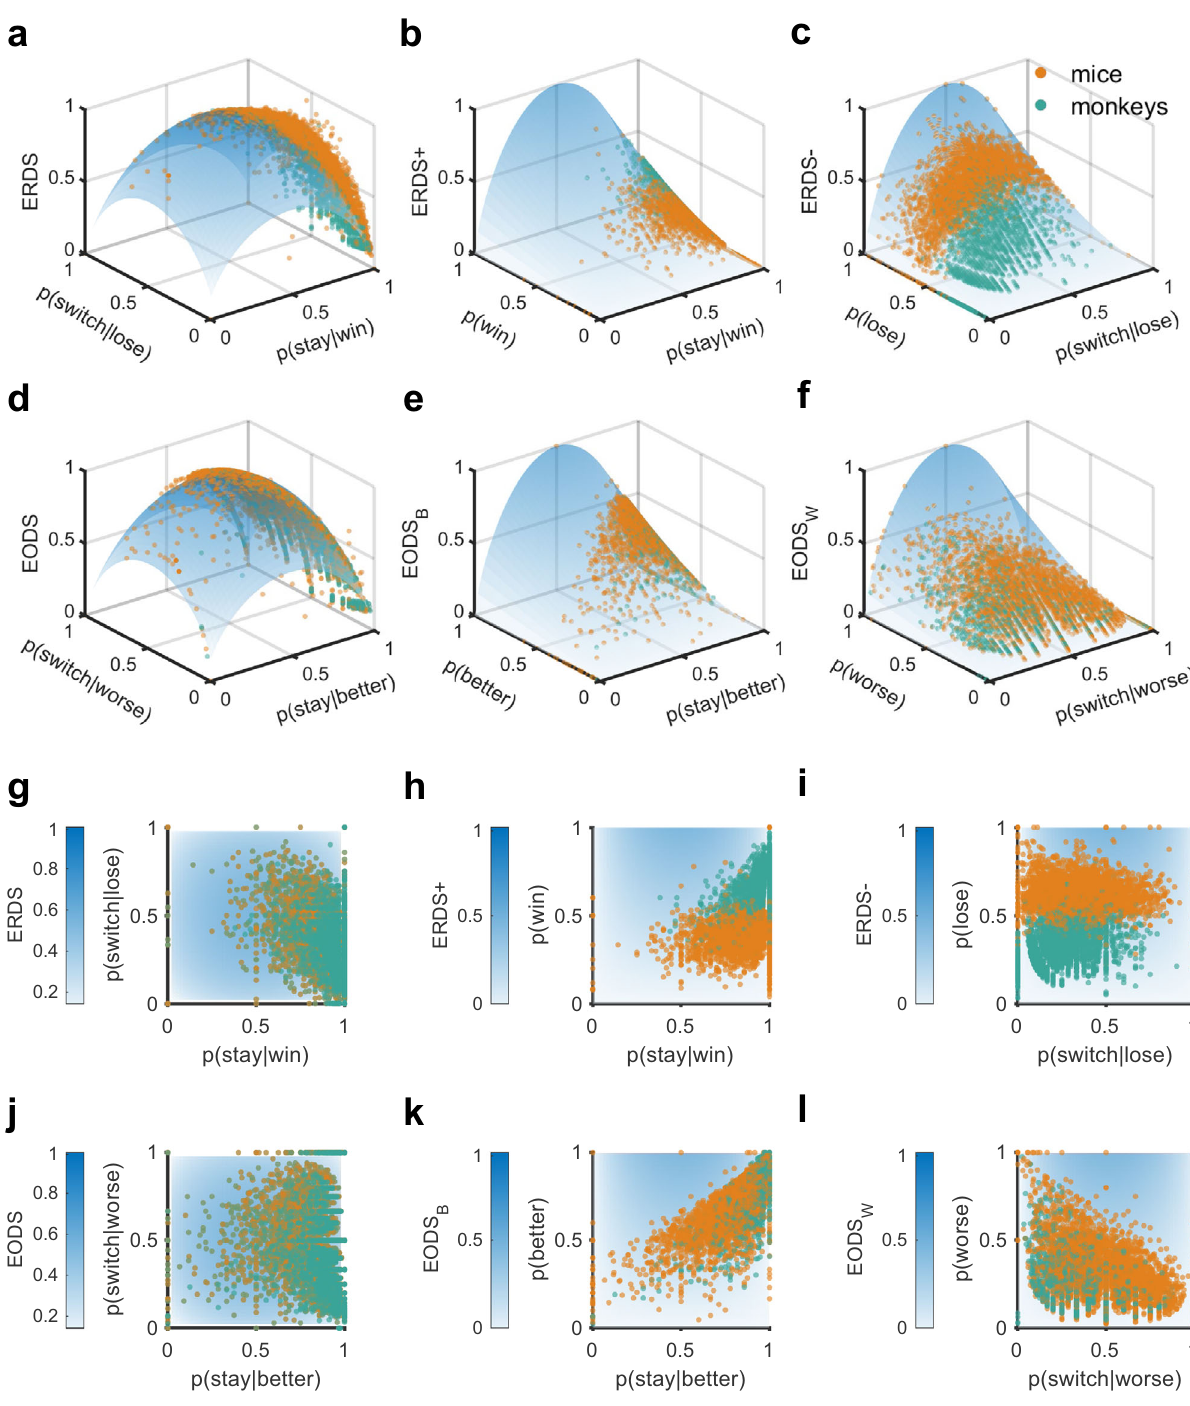
Fig. 3 Relationship between entropy-based metrics and win-stay, lose-switch strategies. a – c Plotted are ERDS and ERDS decompositions for rewarded and unrewarded trials (ERDS + and ERDS − ) as a function of p(win), p(lose), win-stay, and lose-switch. Darker colors correspond to larger values of metrics. For the plot in ( a ), p(win) is set to 0.5. Observed entropy-based metrics and constituent probabilities for each block for mice (orange dots) and monkeys (green dots) are superimposed on surfaces. d – f EODS and EODS decompositions for the better and worse options (EODS B and EODS W ) as a function of the probabilities of choosing the better and worse options, p(better) and p(worse), conditional probability of stay on the better option, and conditional probability of switch from the worse option. For the plot in ( d ), p(better) is set to 0.5. For all plots, the units of entropy-based metrics are bits. g – i Same as in ( a – c ) but using heatmap. j – l Same as in ( d – f ) but using